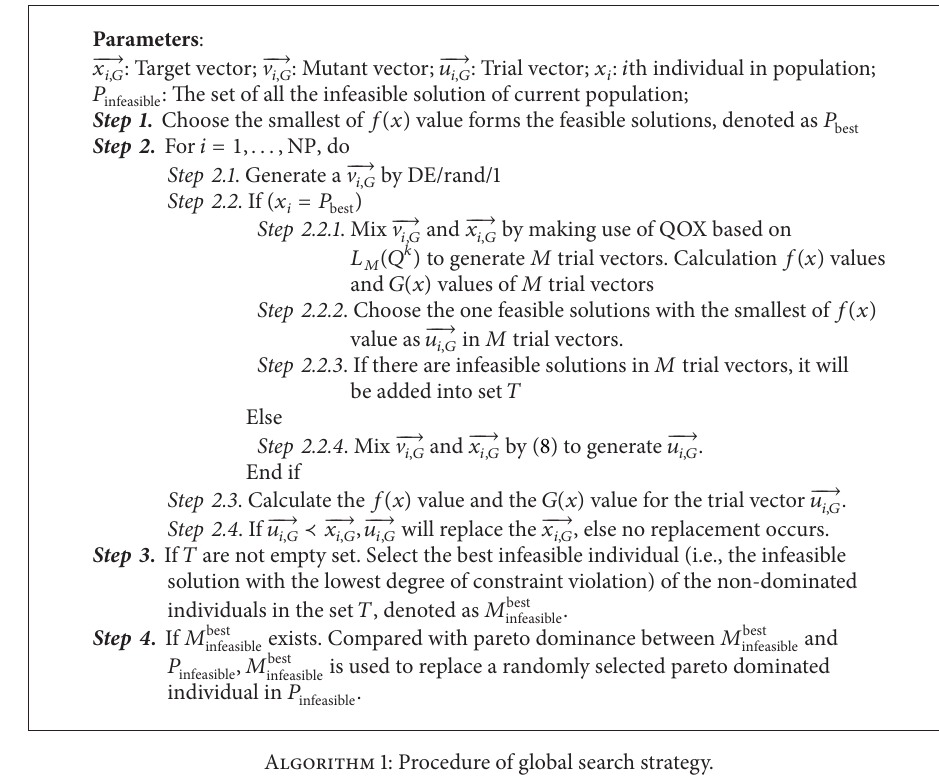
Algorithm 1: Procedure of global search strategy.